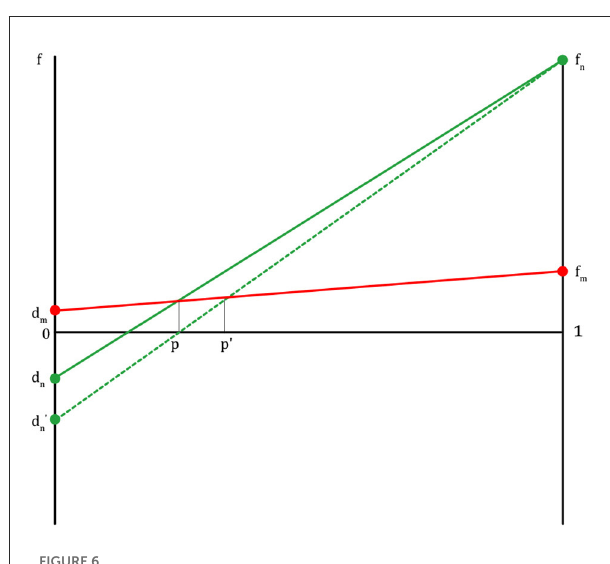
The red-colored and green-colored fitness lines formed by migraineurs and non-migraineurs have the same angle θ , and form two triangles, A and B, are formed, and three sides of each triangle are proportional to each other. The vertical lines of each of the two triangles, A and B,